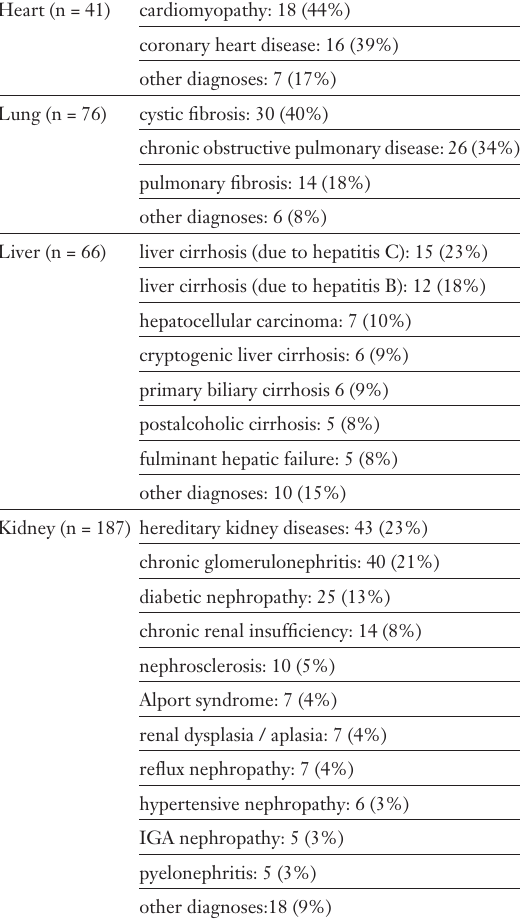
Diagnoses before transplantation, ranked according to frequency (number,